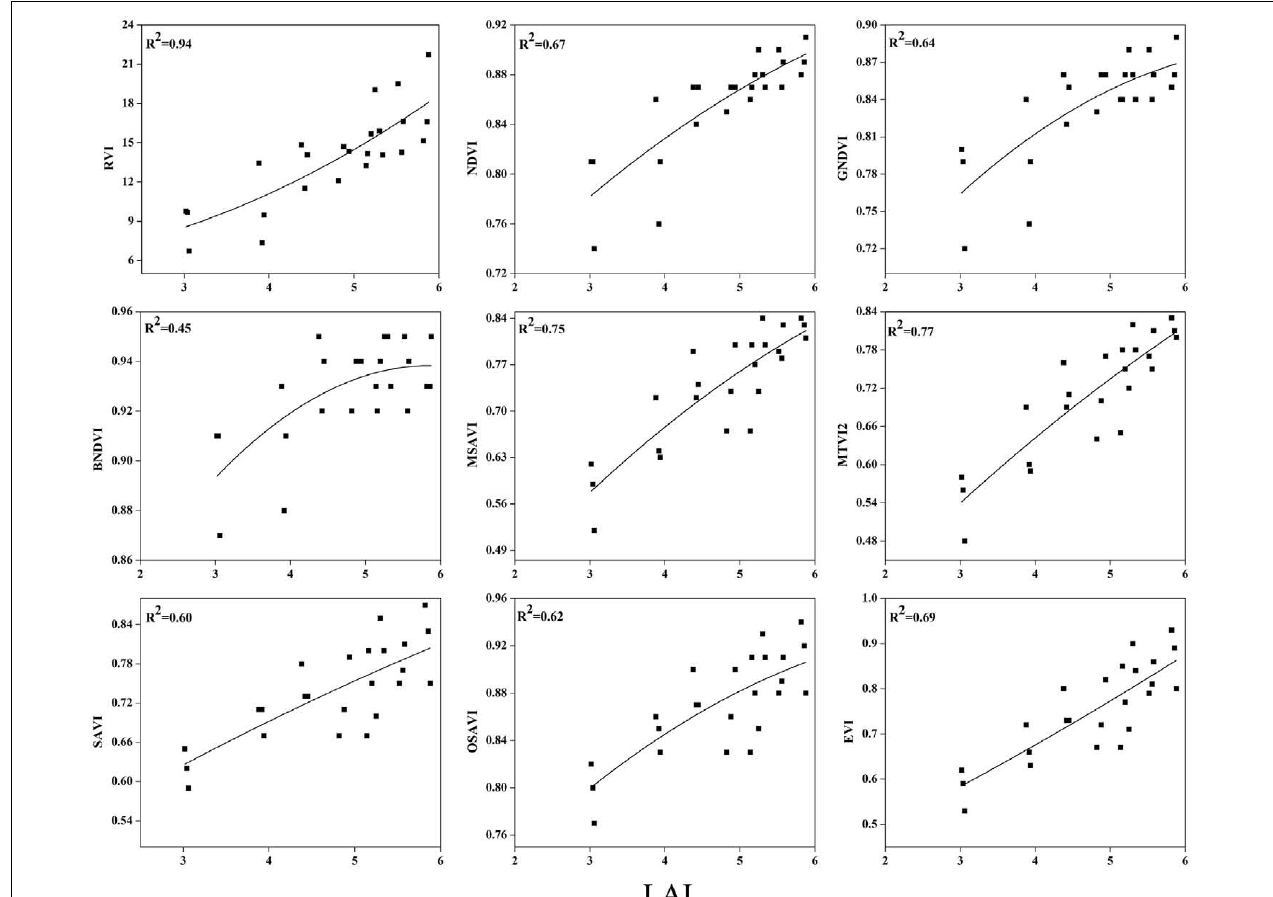
FIGURE 8 | Best-fit models between VIs and LAI at booting